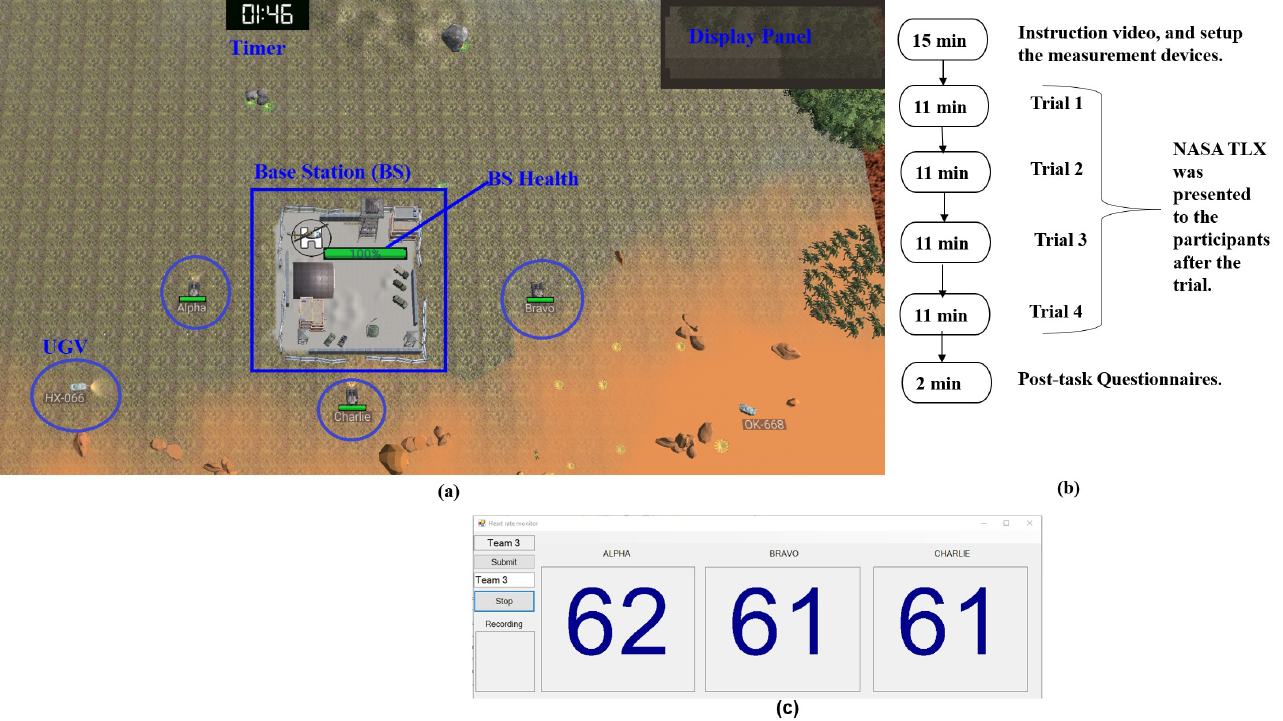
Figure 1. Experimental setup overview and timeline of the experiment. ( a ) Operating window. ( b ) The estimated timeline of the experiment. ( c ) Custom data app developed to interface the three Polar H10 sensors, the values represent the instantaneous heart rate in beats per minute for each of the